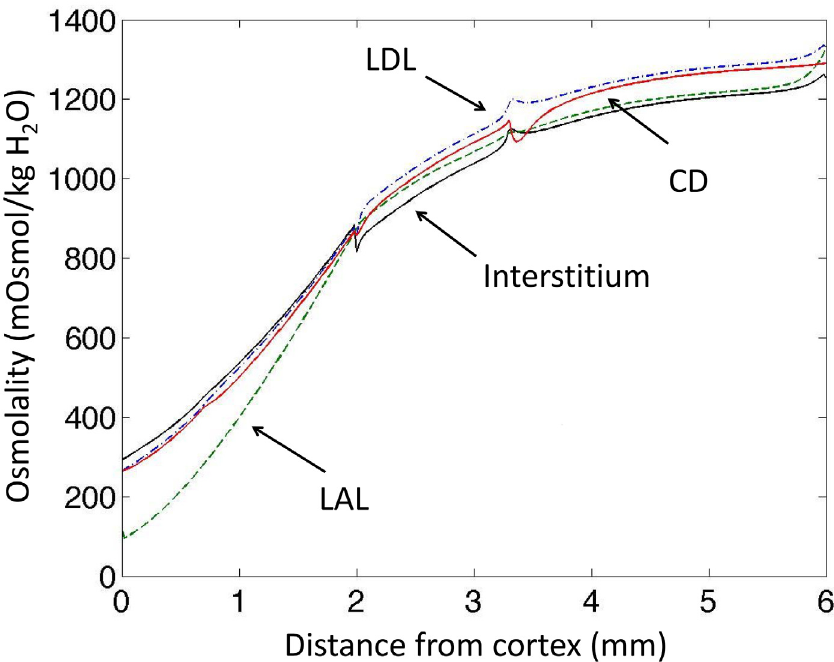
Fig 2. Model results: osmolality gradients (mOsm/KgH 2 O). The osmolality increases in the inner medulla thanks to our introduction of interstitial external osmoles as a surrogate concentration mechanism in the inner medulla. In our model, transport parameters are defined for each region (OS, IS, UIM and LIM), and therefore small discontinuities can be observed around the junctions of the regions.